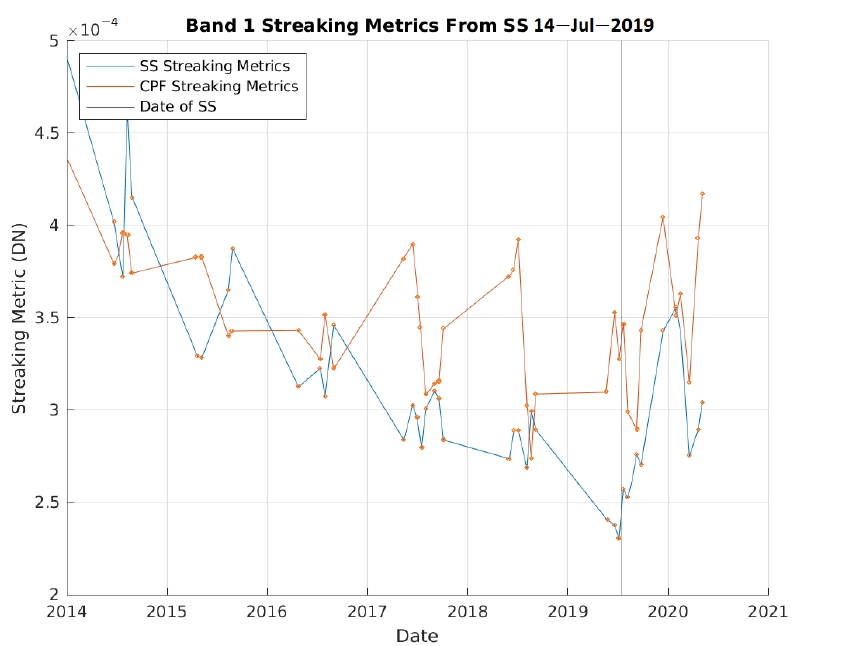
Figure 14. Timeline of Streaking Metric averages for Greenland side–slither relative gains (Y2019 D195) applied to all North Africa scenes compared with the CPF relative gains Streaking Metric averages applied to the same